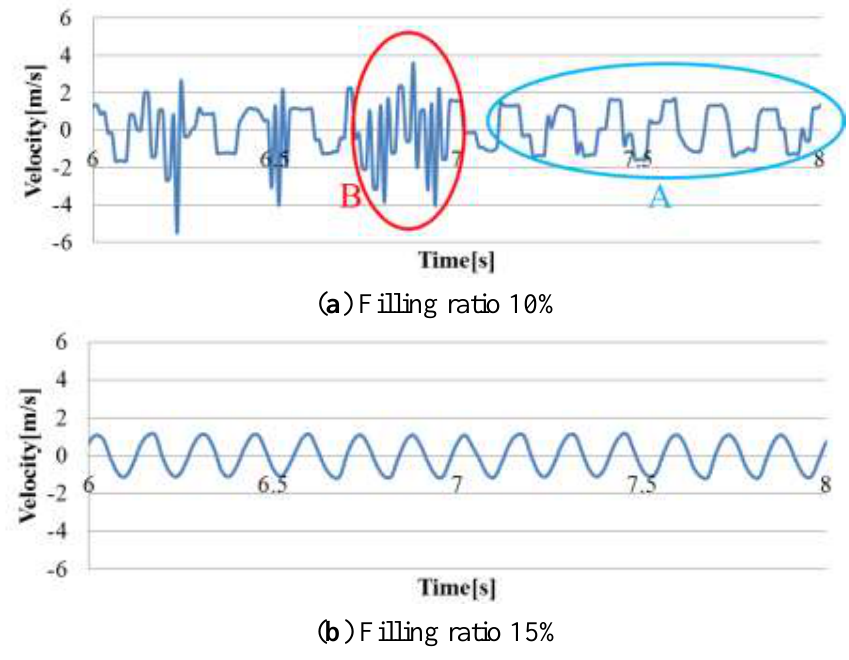
Figure 8. Example of time history response of velocity in Figure